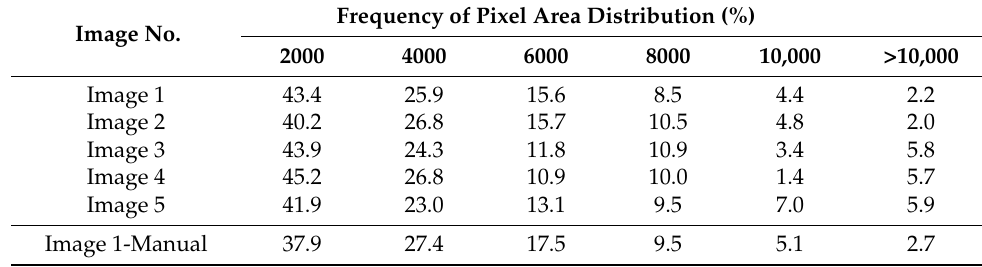
Table 1. The frequency of rock pixel area distribution from images 1 to 5, compared with manual results of image 1. Image No.